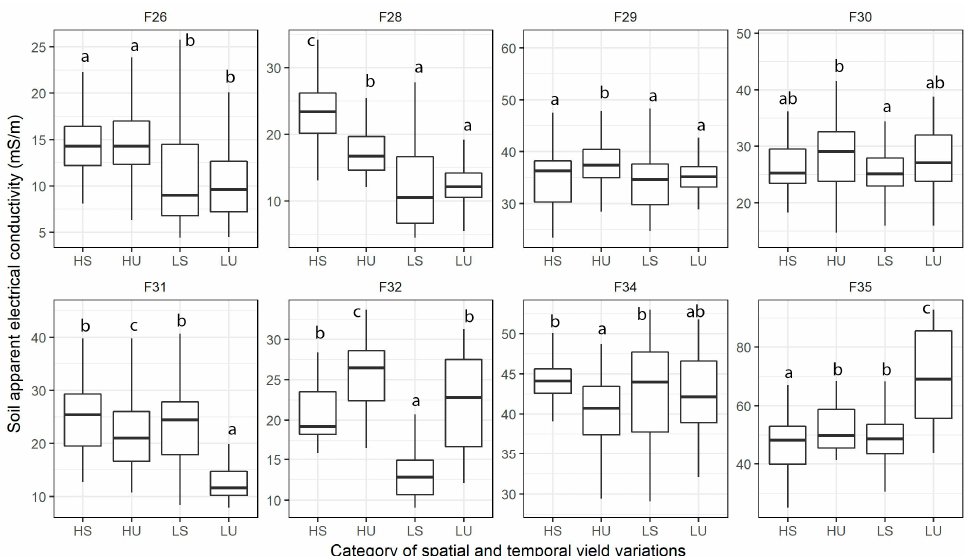
Figure 10. Relationship between spatial temporal yield variations of cotton yield and distribution of soil apparent electrical conductivity (EC a ) in eight fields in the Southern High Plains 2000–2003. HS: high yield and stable; HU: high yield and unstable; LS: low yield and stable; LU: low yield and unstable. Letters on top of boxes mark significant differences in EC a between spatial and temporal yield pattern groups. Pairs of groups that are not significantly different from one another share the same letter ( p < 0.05).